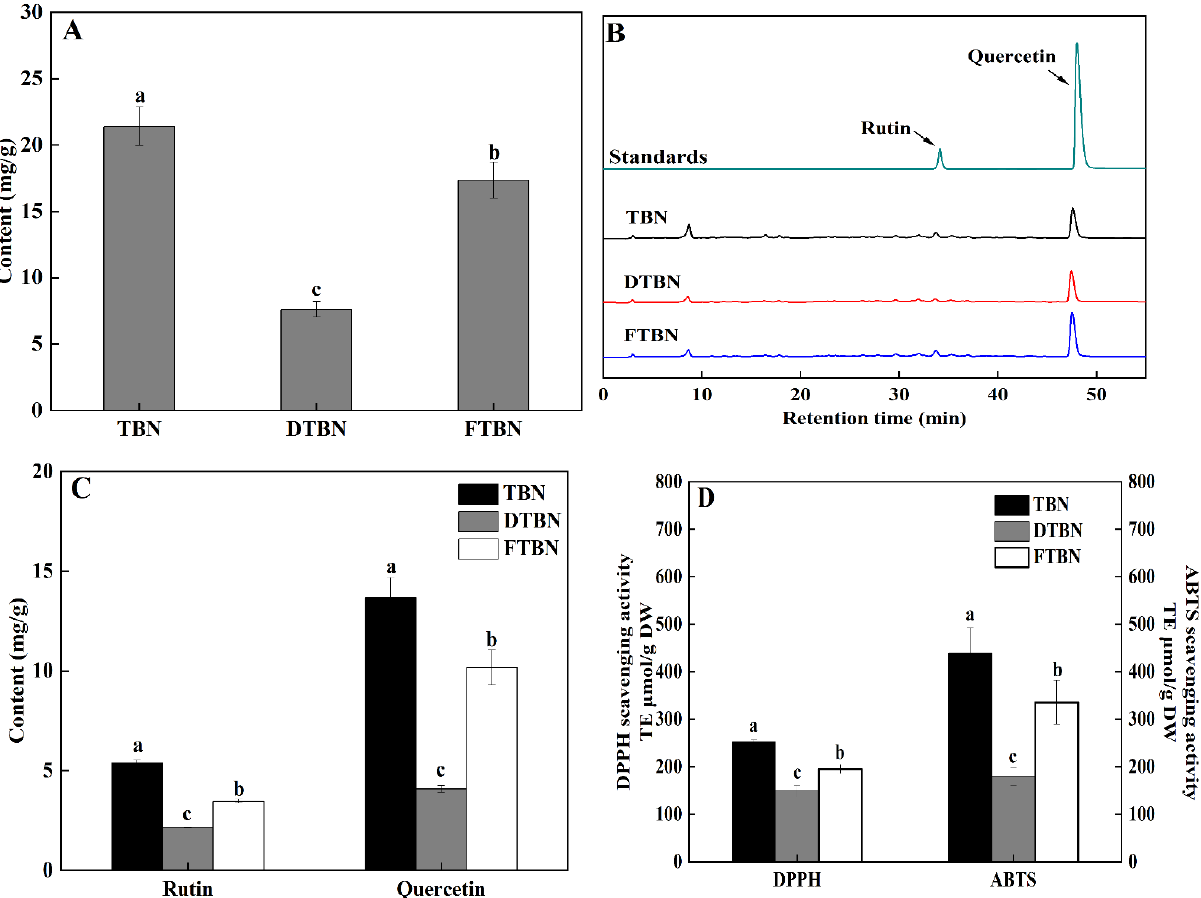
Figure 4. Functional property of Tartary buckwheat noodles. Total flavonoid content ( A ); High- Performance Liquid Chromatography (HPLC) of quercetin and rutin ( B ); quercetin and rutin con- tents ( C ); DPPH and ABTS scavenging activities ( D ). TBN, fresh Tartary buckwheat noodles; DTBN, dried Tartary buckwheat noodles; FTBN, frozen Tartary buckwheat noodles. Different letters in the same figure imply that the values are significantly different ( p < 0.05).